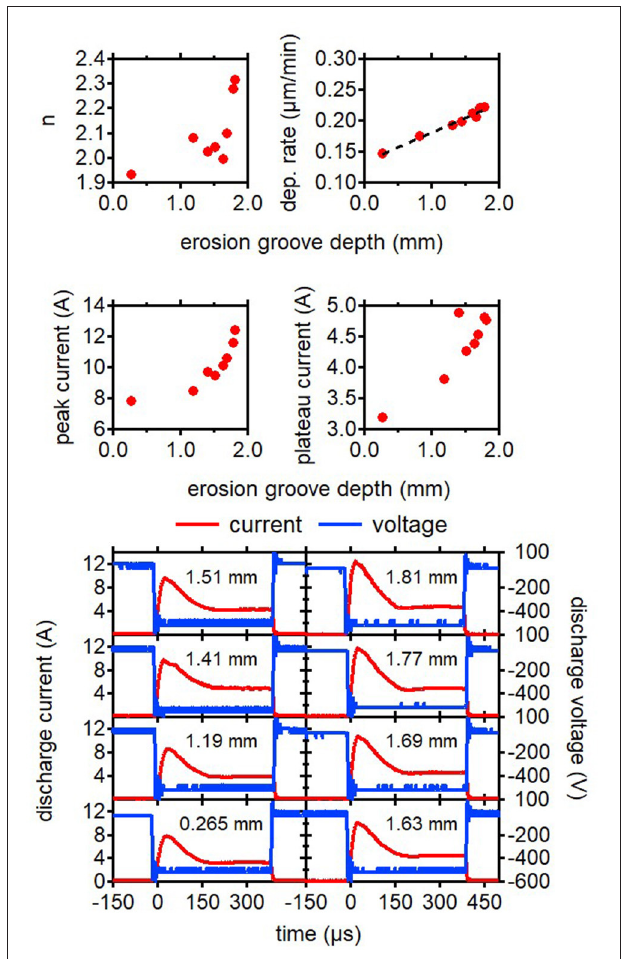
FIGURE 2 | The current and voltage pulse measured for Mg for different erosion groove depths. The peak current and the plateau current as a function of the erosion depth is shown in the top panels. The left top panel shows the slope of the I-V characteristic. The latter was determined by fitting the kV n to the experimental data. Correlation coefficients empirical function I = larger than 0.95 were obtained for all fits. To avoid any influence of target contamination only experiments with an average discharge power above 75 W were used. The right top panel shows the measured deposition rate as a function of the erosion groove depth. The argon pressure was fixed at 1.8 Pa for all shown results. For the deposition experiments, a 500 V rectangular pulse was applied for 400 µ s. The duty cycle was set equal to 10%.